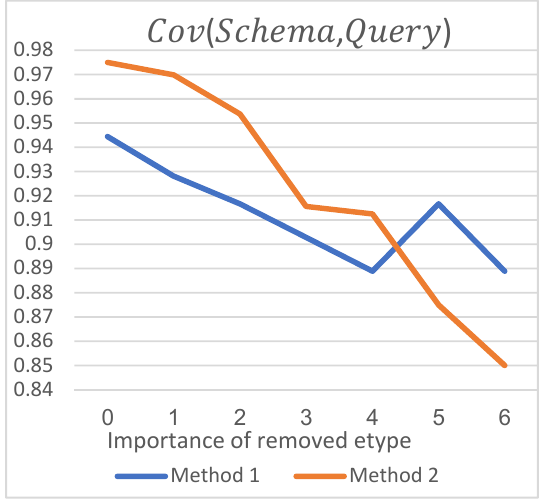
Figure 8. Coverage of Schema to Query.